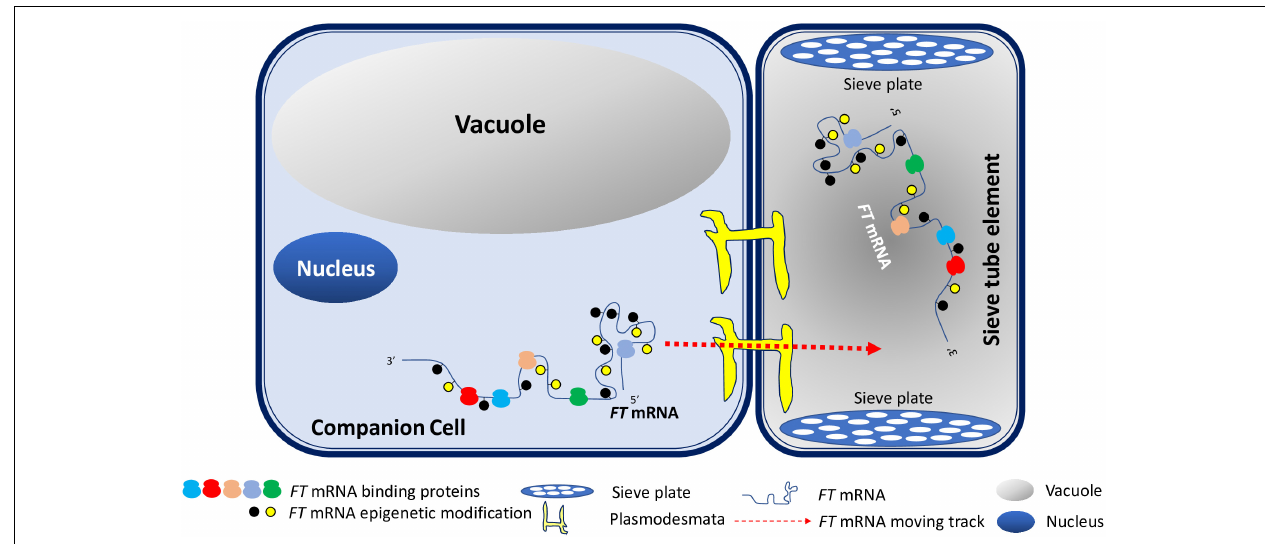
FIGURE 1 | A Model for FT mRNA Signaling. In companion cells, FT mRNAs may be epigenetically modified and form specific structures such as tRNA-like secondary structures. Such structured RNAs may then be recognized by RNA-binding proteins and transported through plasmodesmata into sieve tube. FT mRNAs will travel pass sieve plates through phloem to germline cells in shoot apical meristem to induce flowering along with other floral induction factors.